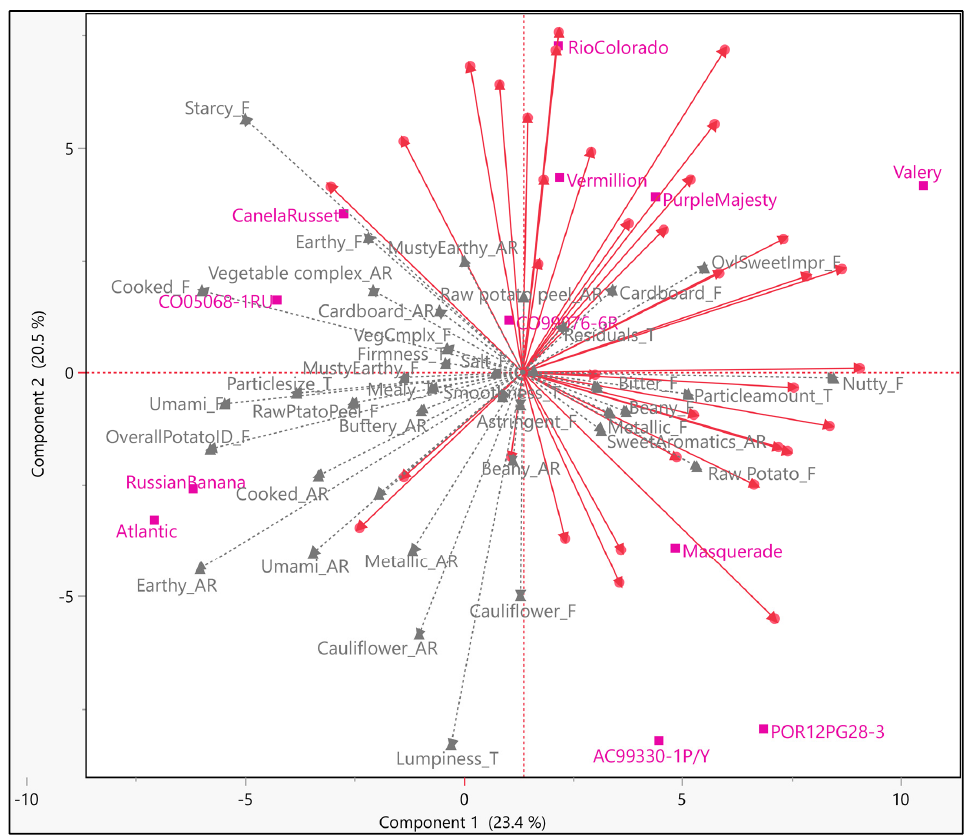
Figure 5. Internal Preference Mapping (IPM) plot for the third segment of respondents ( N = 35); magenta colored markers ■ and labels—samples; gray colored markers ▲ and labels—sensory descriptors; red colored markers ● and vectors—participants/consumers. Foods 2020 , 9 , x FOR PEER REVIEW